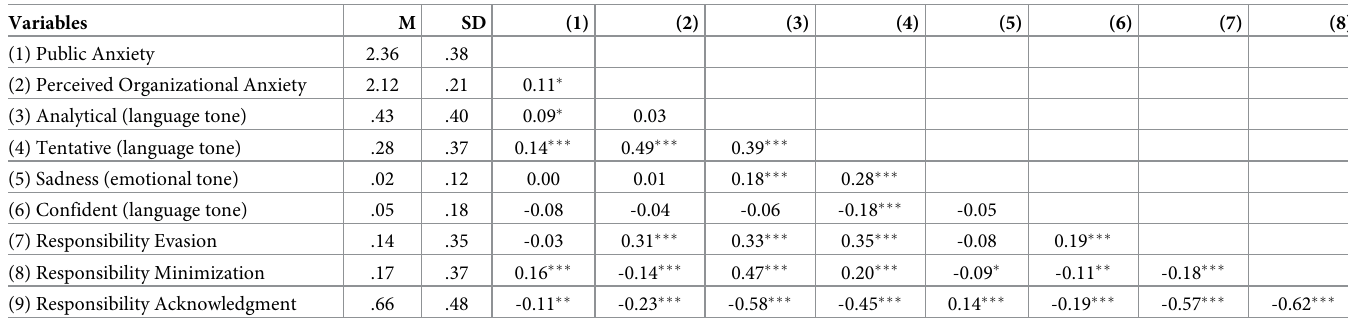
Table 1. Pairwise correlations of main variables.